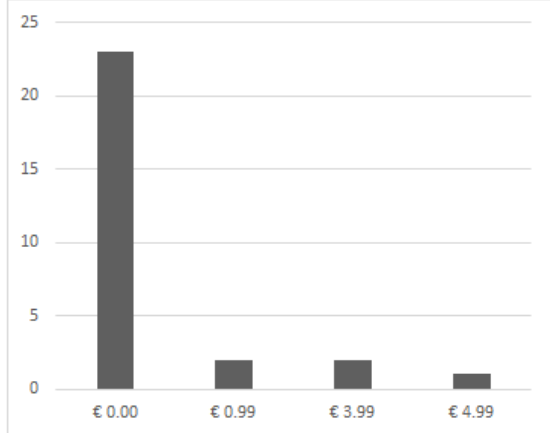
Figure 3. Number of apps per price category (N=28).